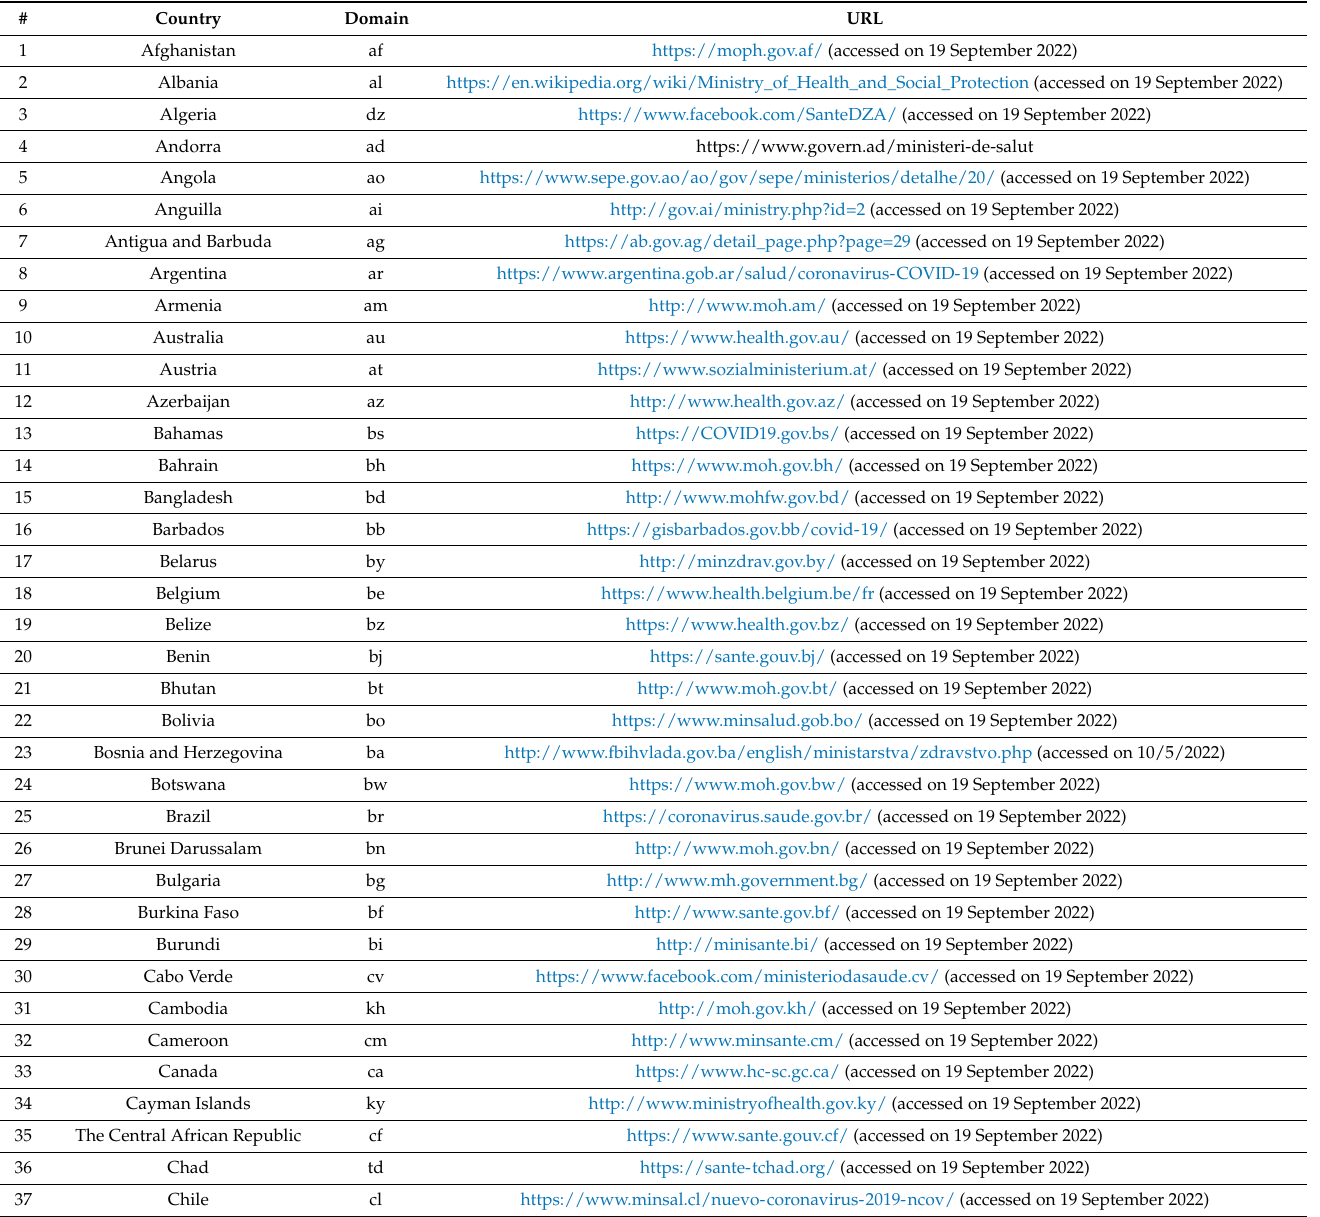
Table 3. Sample of the first 40 websites evaluated.